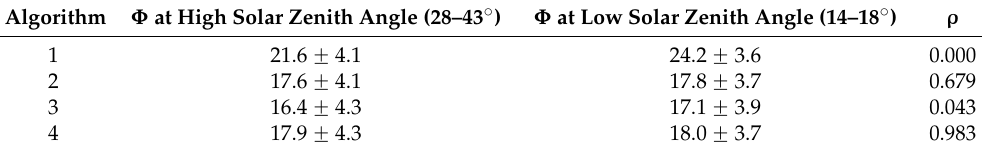
Table 2. Olive crown porosity ( Φ ) measurements depending on solar zenith angle. Values are mean ± standard deviation. Significance ( ρ ) was calculated according to Wilcoxon signed rank test. ρ = 1 indicated that both measurements were equal and that the method was robust against solar zenith angle.